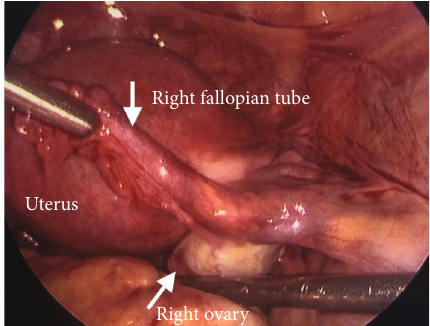
Figure 3: Laparoscopic image of unremarkable right fallopian tube and right ovary.